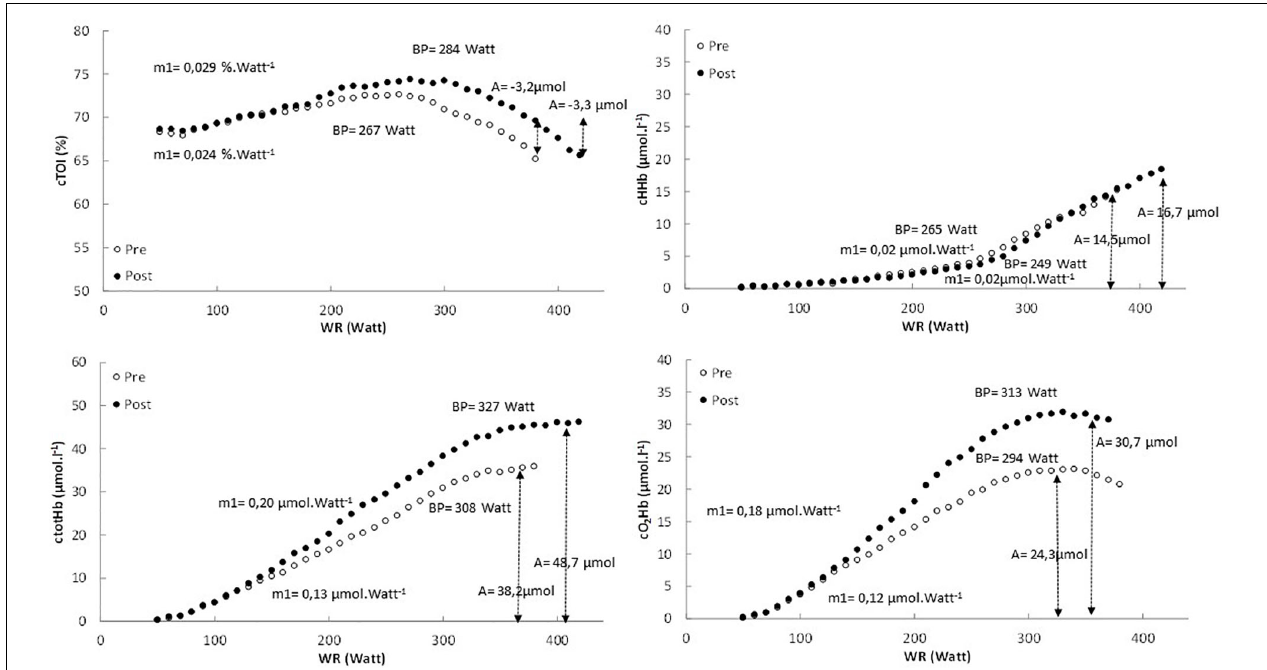
FIGURE 2 | The pattern of cTOI, cHHb, ctotHb, and cO 2 Hb expressed as a function of power output for the pretest (white dots) and posttest (black dots) in a representative